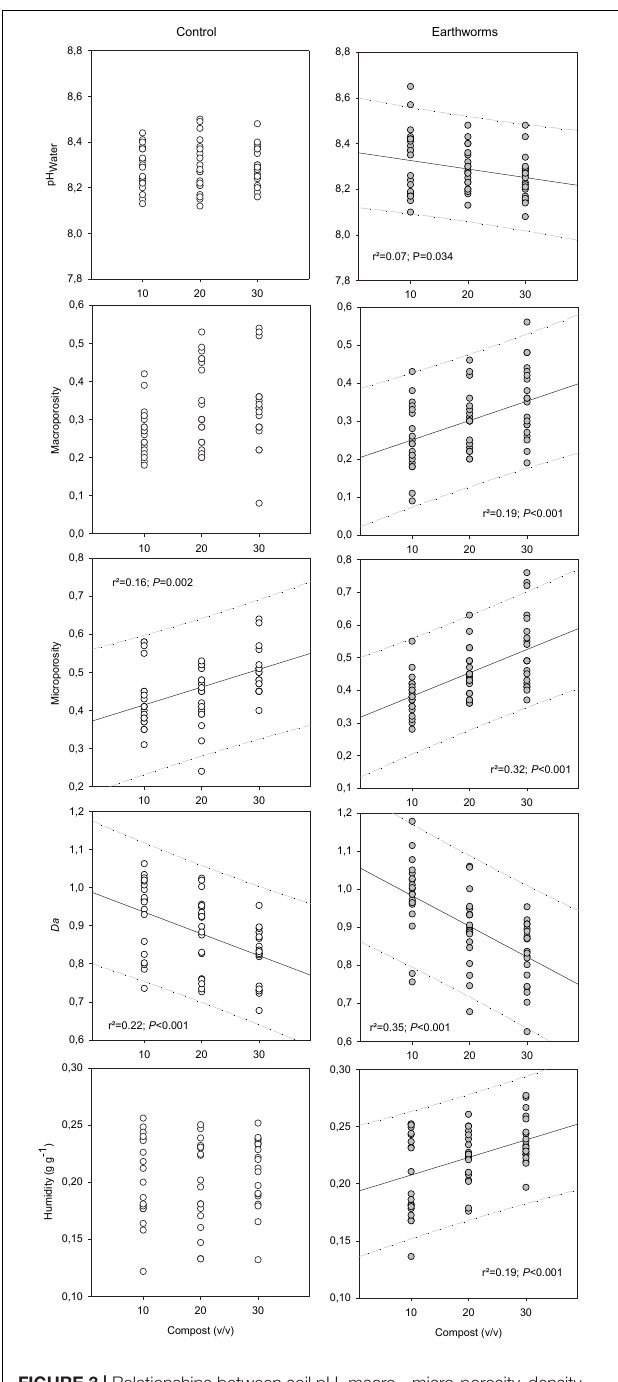
FIGURE 3 | Relationships between soil pH, macro-, micro-porosity, density and humidity and the compost proportion in Technosols with (gray, right) or without (white, left) earthworms. Solid lines represents the linear regression when the model is significant ( P < 0.05; n = 60). Dotted-lines represent the 95% confidence